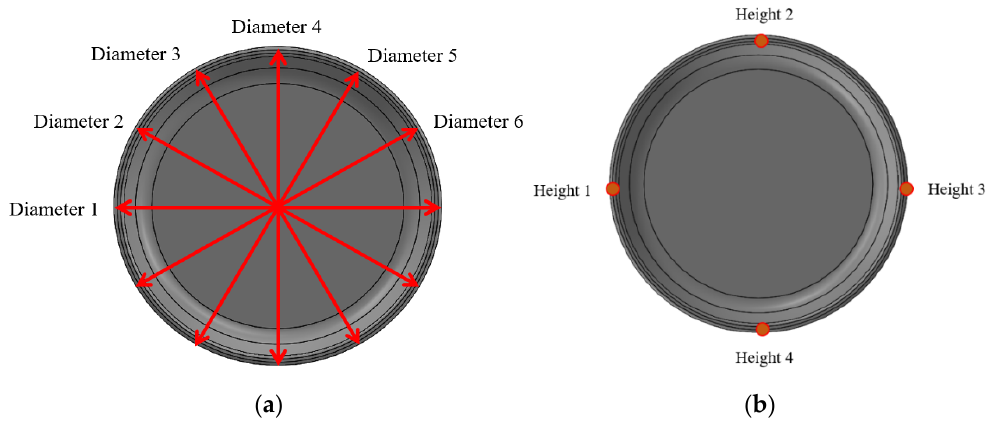
Figure 3. Measurement points for ( a ) diameter and ( b ) height.